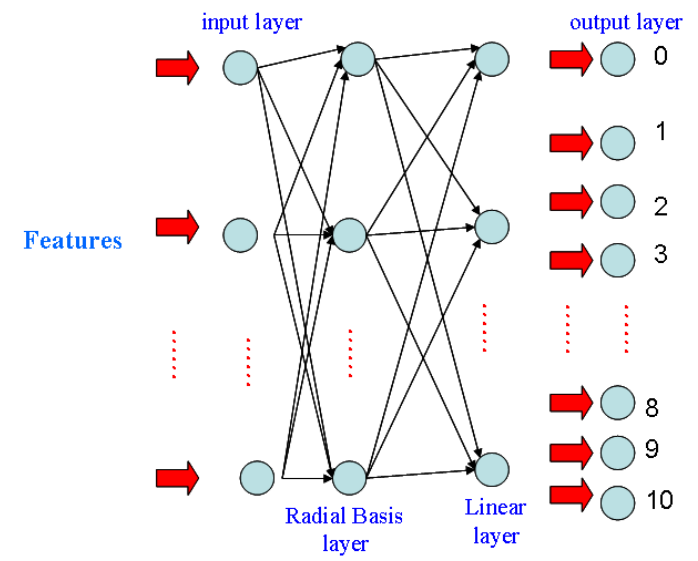
Figure 4. Radial basis function neural network-based